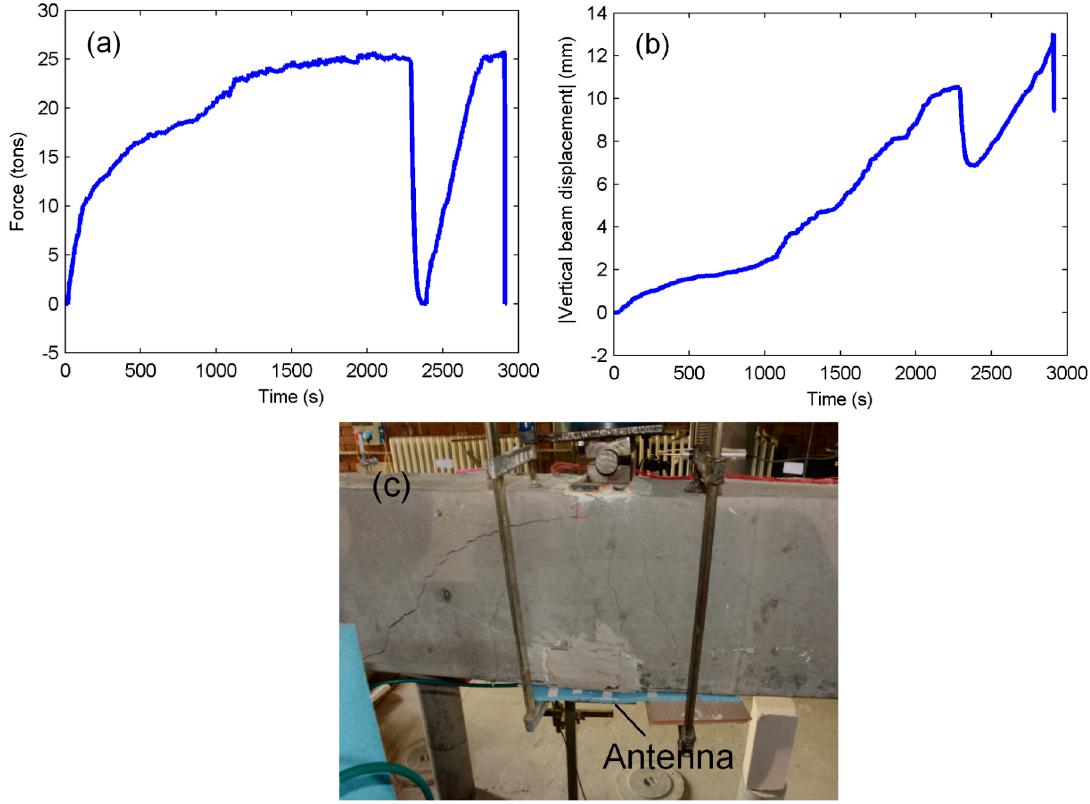
Figure 8. Plastic deformation region measurements: ( a ) applied vertical force read from the load cell; ( b ) absolute vertical displacement of the midpoint at the bottom of the beam, LVDT reading; and ( c ) the beam sample with visible cracks after the experiments.